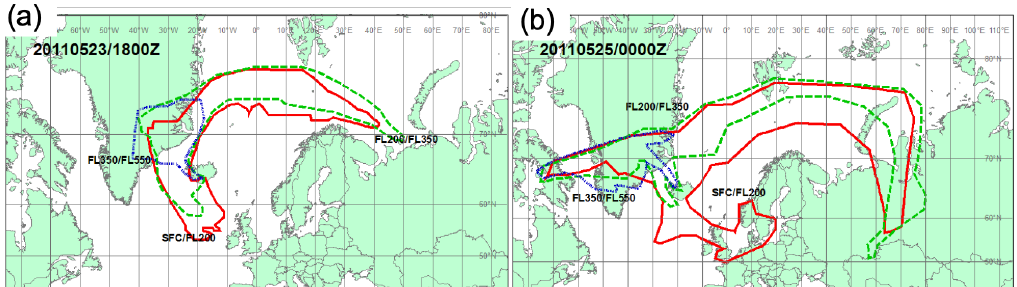
Figure 3. Volcanic ash advisory graphics issued by the London VAAC at ( a ) 1800 UTC on 23 May 2011 and ( b ) 0000 UTC on 25 May 2011 taken from the London VAAC: Volcanic ash advisories and graphics archive [67]. Contours show the outermost extent of the ash cloud in 3 layers of the atmosphere: surface—flight level (FL) 200 (red), FL200-350 (green) and FL350-550